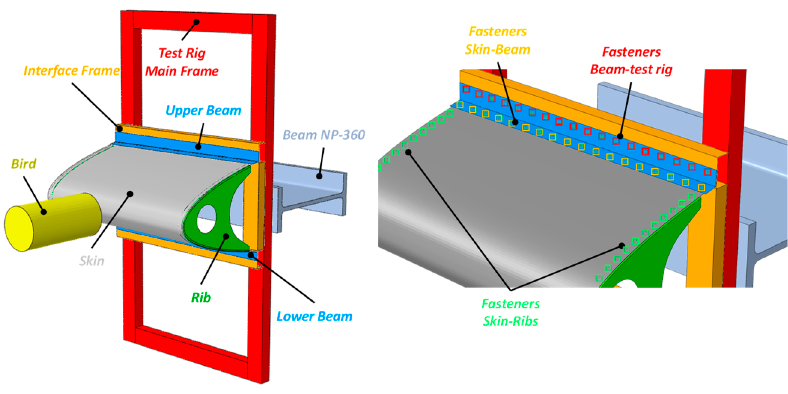
Figure 2. Numerical model. Test article and test rig.